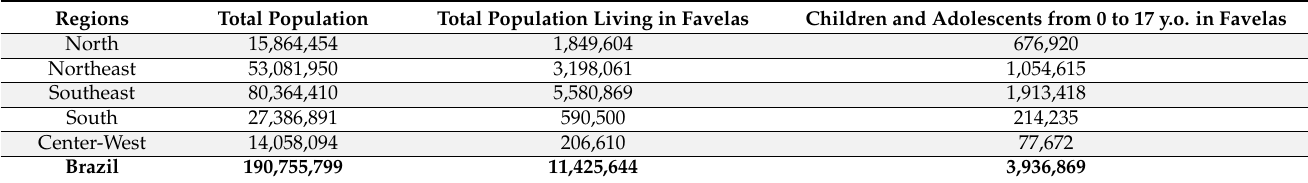
Table 1. Population living in favela households in each Regional Division—2010 [33]. Regions Total Population Total Population Living in Favelas Children and Adolescents from 0 to 17 y.o. in Favelas